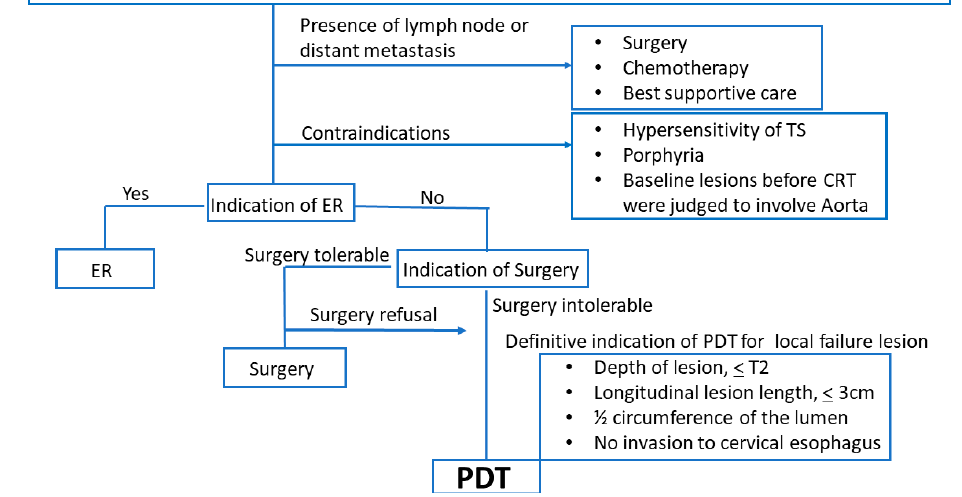
Figure 3. A clinical flowchart for the indication of PDT using talaporfin sodium for esophageal cancer